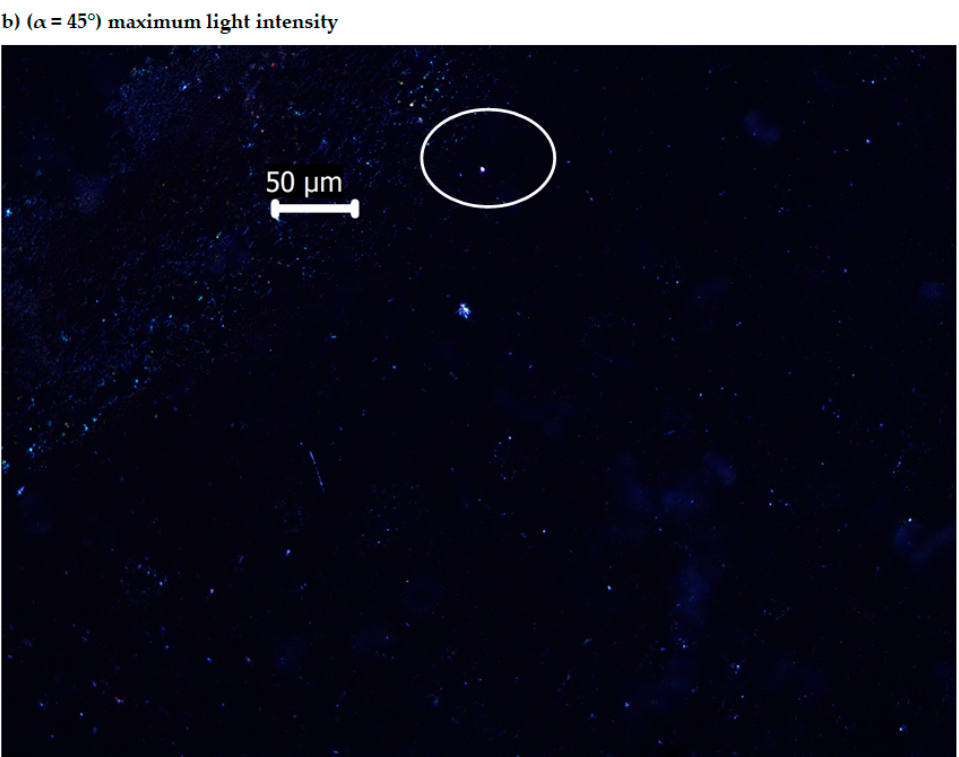
Figure 11. Optical images of BTA ( c = 1%) with crossed polarizers.